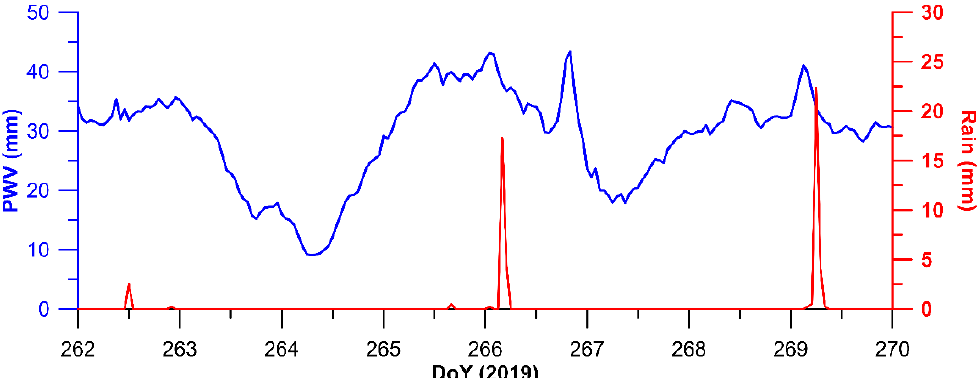
Figure 9 . PWV at MAFE GPS station retrieved from GAMIT/GLOBK analysis (blue curve) and rainfall amount on the occasions of two thunderstorms (DoY 266, 269 = 23, 26 September 2019).